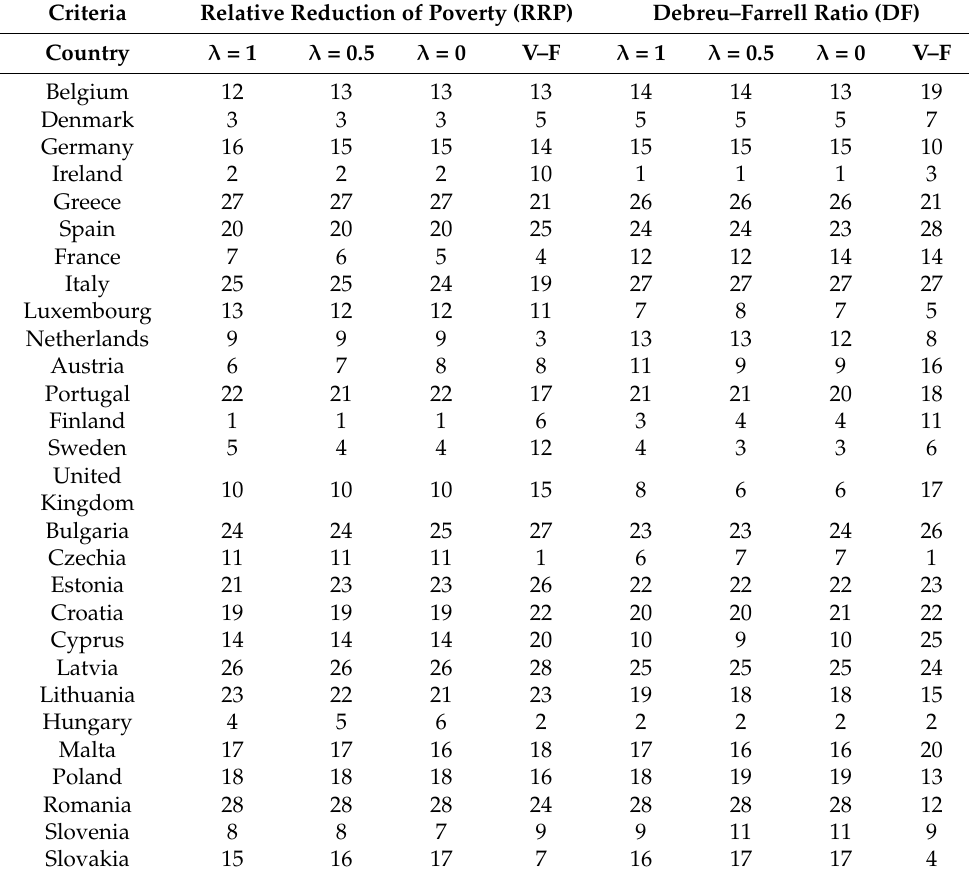
Table 10a. Ranking social policy in UE-28 countries on the basis of the expected value of RRP and DF in Table A2 for several values of λ .